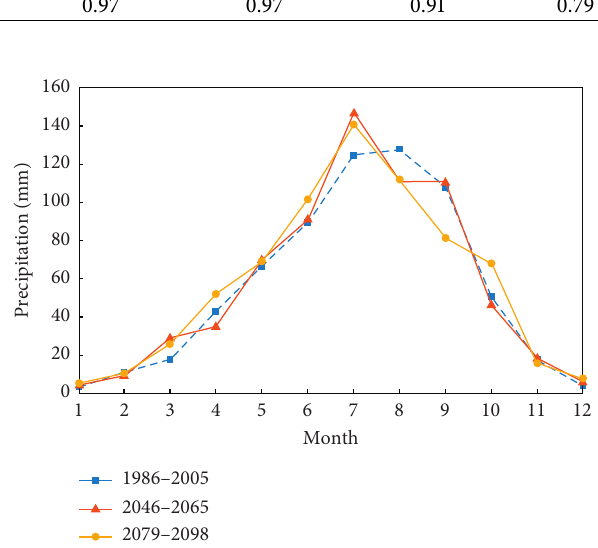
Figure 5: Projected annual cycles of monthly mean